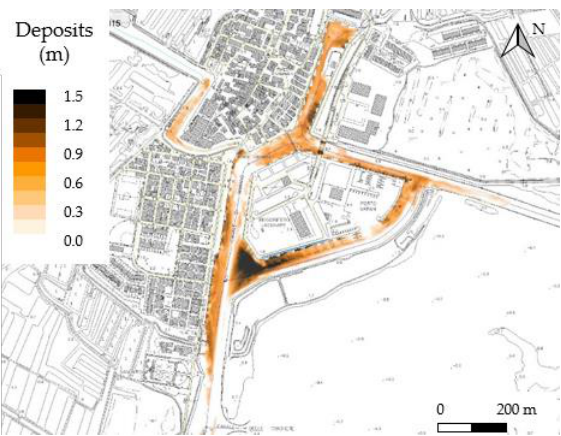
Figure 3. Consecutive surveys in the port: bottom height superimposed onto regional cartography from 2003. ( a ) Bottom height after the dredging works in 2015; the black line indicates the area where a minimum water depth of 2.5 m is guaranteed; ( b ) Bottom height in 2019.